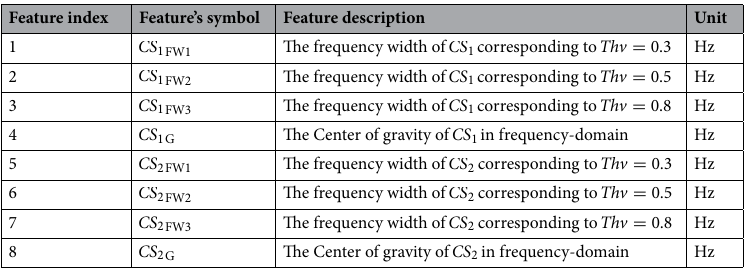
Table 1. Description of the frequency domain feature matrix FF .